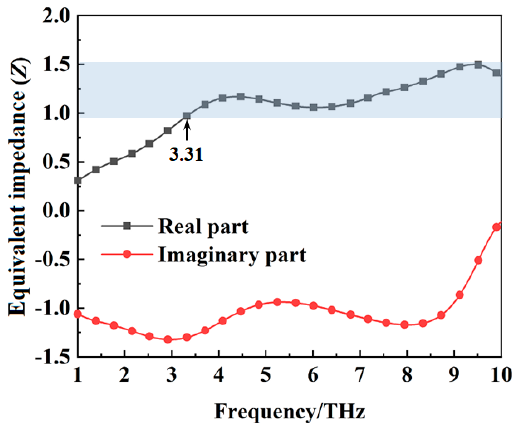
Figure 3. The S parameters of the metamaterial absorber when the conductivity of VO 2 film is 10 S/m.